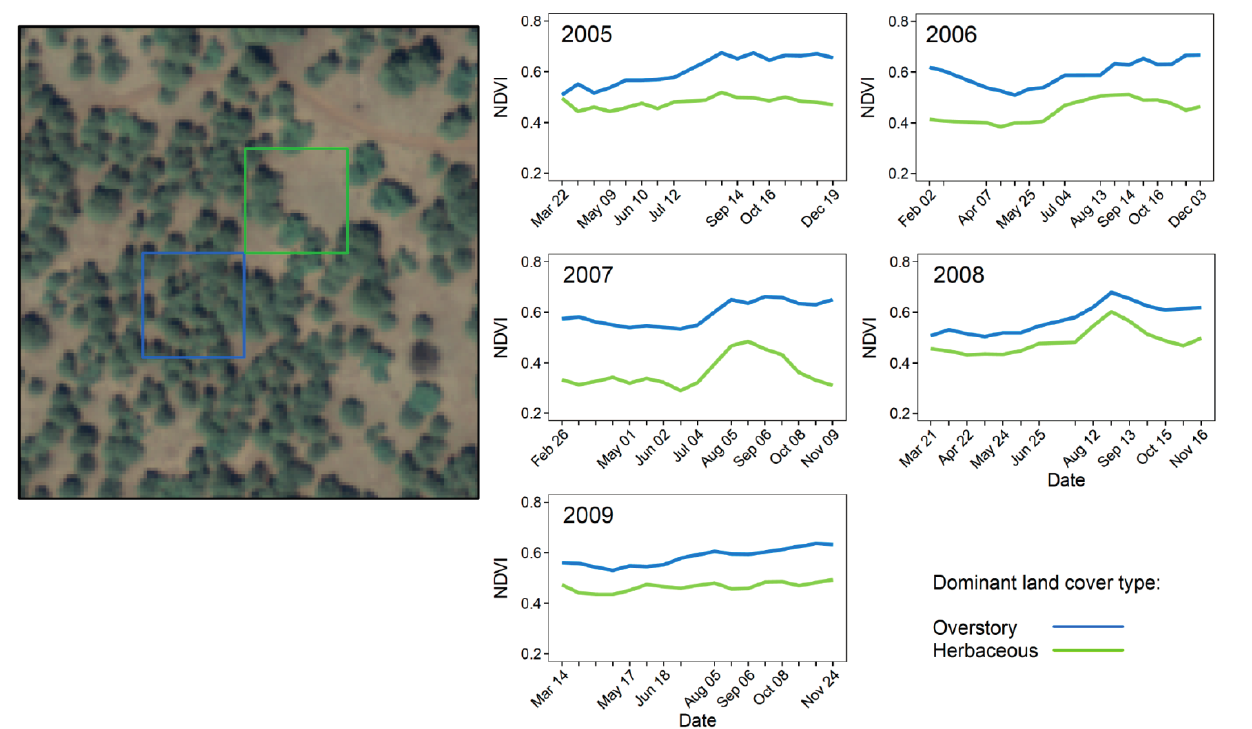
Figure 4. Examples of seasonal differences in NDVI timing and value of herbaceous and woody vegetation. Shown are neighboring 30-m STARFM ponderosa pine land cover pixels dominated by overstory ponderosa pine (blue) or herbaceous vegetation (green). The background is 1-m resolution, natural-color U.S. Department of Agriculture (USDA) digital orthophoto quarter quad (DOQQ) imagery from June, 2007.